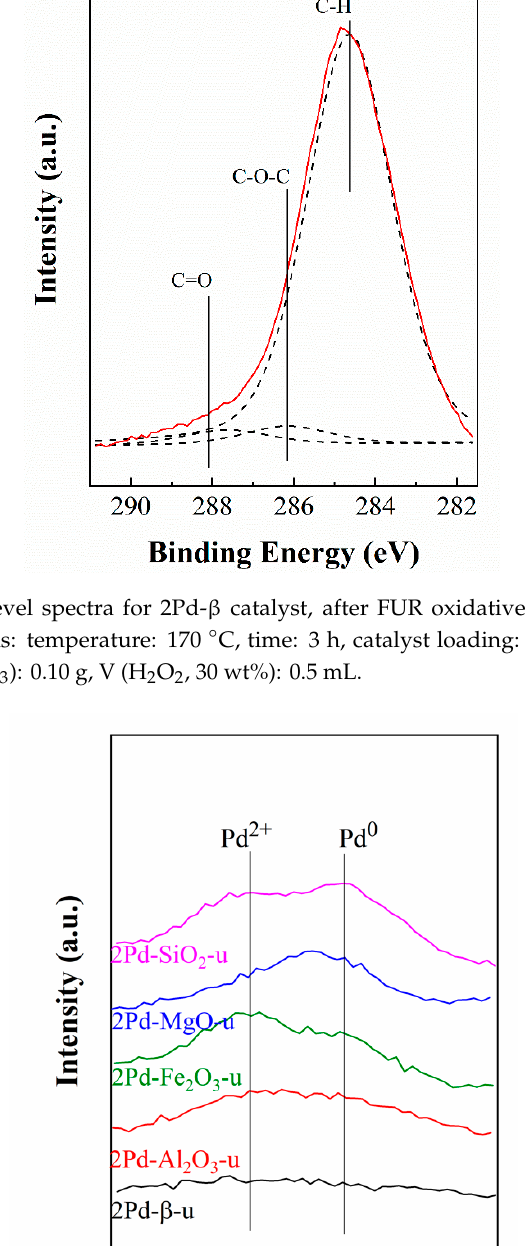
Figure 14. Thermogravimetric analysis of Pd-based catalysts, after FUR oxidative condensation reaction. Experimental conditions: temperature: 170 °C, time: 3 h, catalyst loading: 0.05 g, V (ethanol) :6 mL, amount of base (Na 2 CO 3 ): 0.10 g, V (H 2 O 2 , 30 wt%): 0.5 mL. 4. Materials and Methods 4.1. Synthesis of the Catalysts Pd-based catalysts were synthesized from PdCl 2 (Pressure Chemical CO., Smallman St., Pittsburgh, PA, USA), which was dissolved in HCl (VWR, Fontenay sous Bois, France) to obtain a solution of H 2 PdCl 4 0.01 M. Then, this acid was used to incorporate Pd species on several supports,